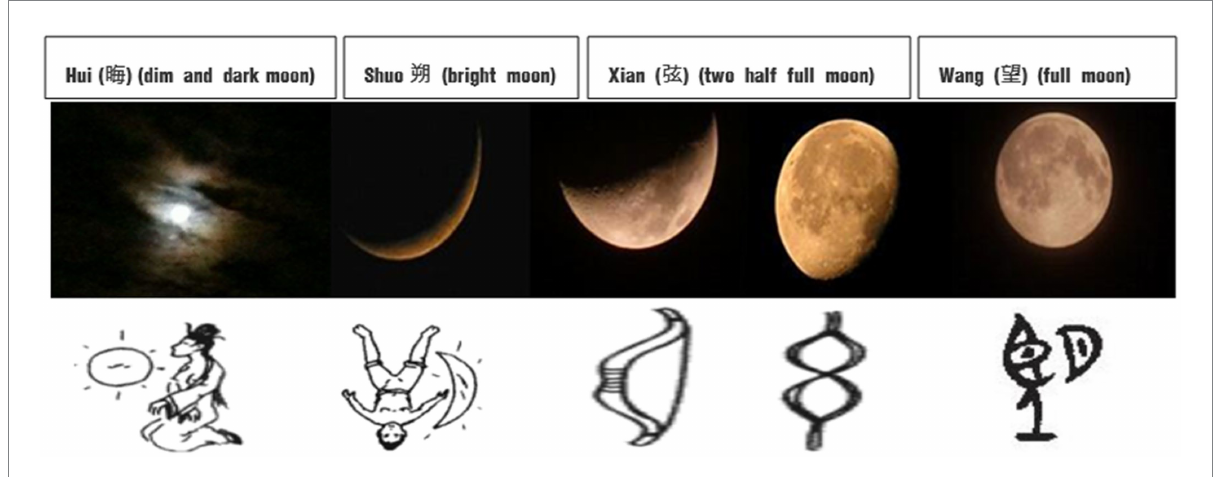
FIGURE 7 Glyphs of phases of the moon [Oracle Script and Bronze